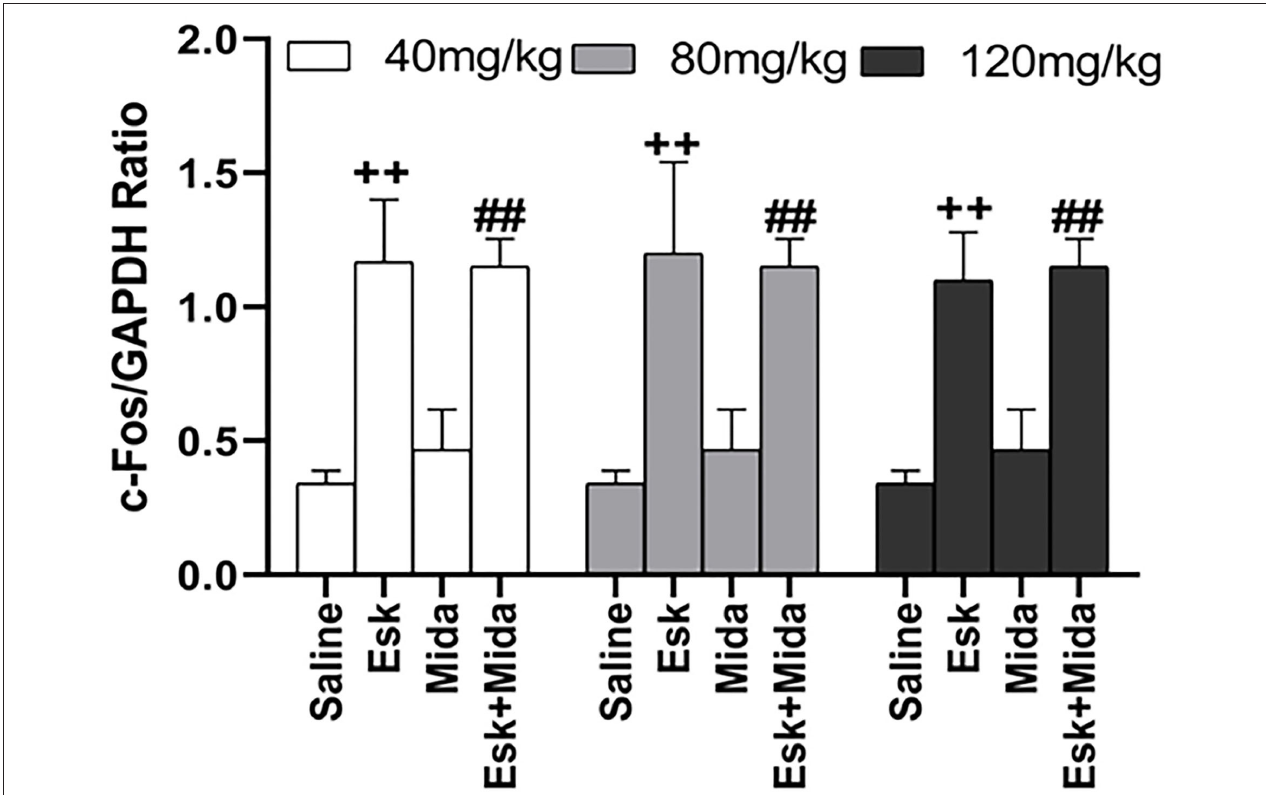
FIGURE 7 | Groups analysis of c-Fos expression over GAPDH ratio in mice brain after recovery from combination of esketamine and midazolam. ++ P < 0.01, compared to saline group. ## P < 0.01, compared to Mida group.